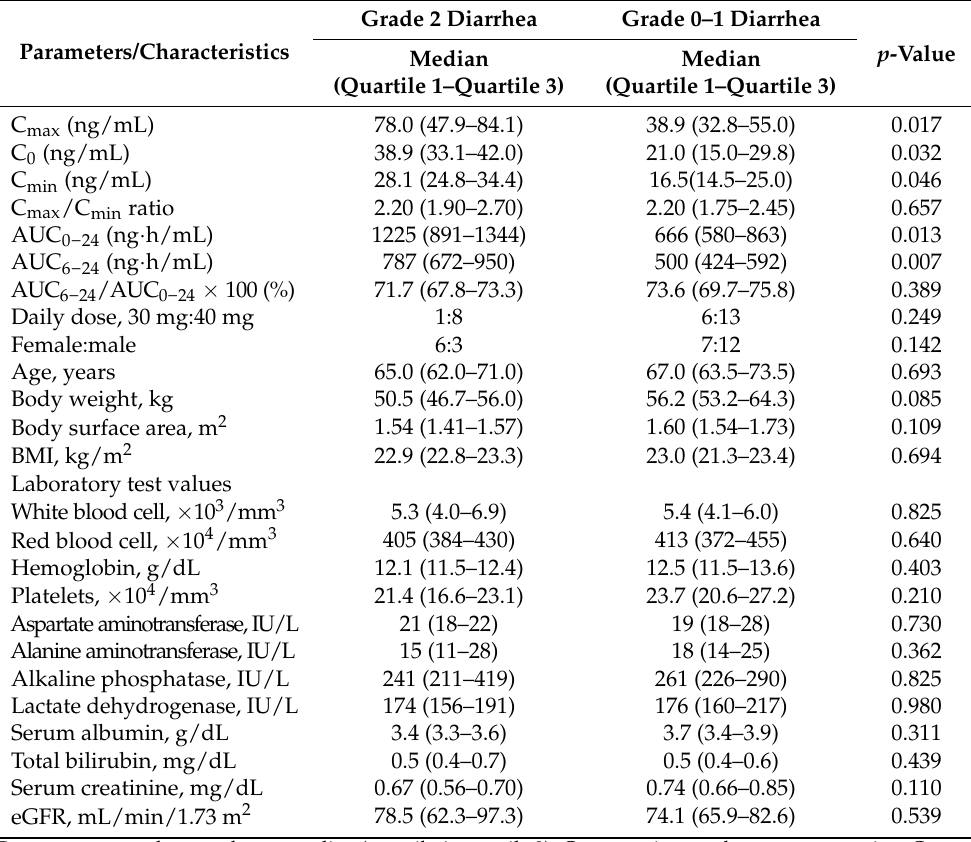
Table 3. Comparison of pharmacokinetics of afatinib and characteristics between patients with grades 2 and 0–1 diarrhea.